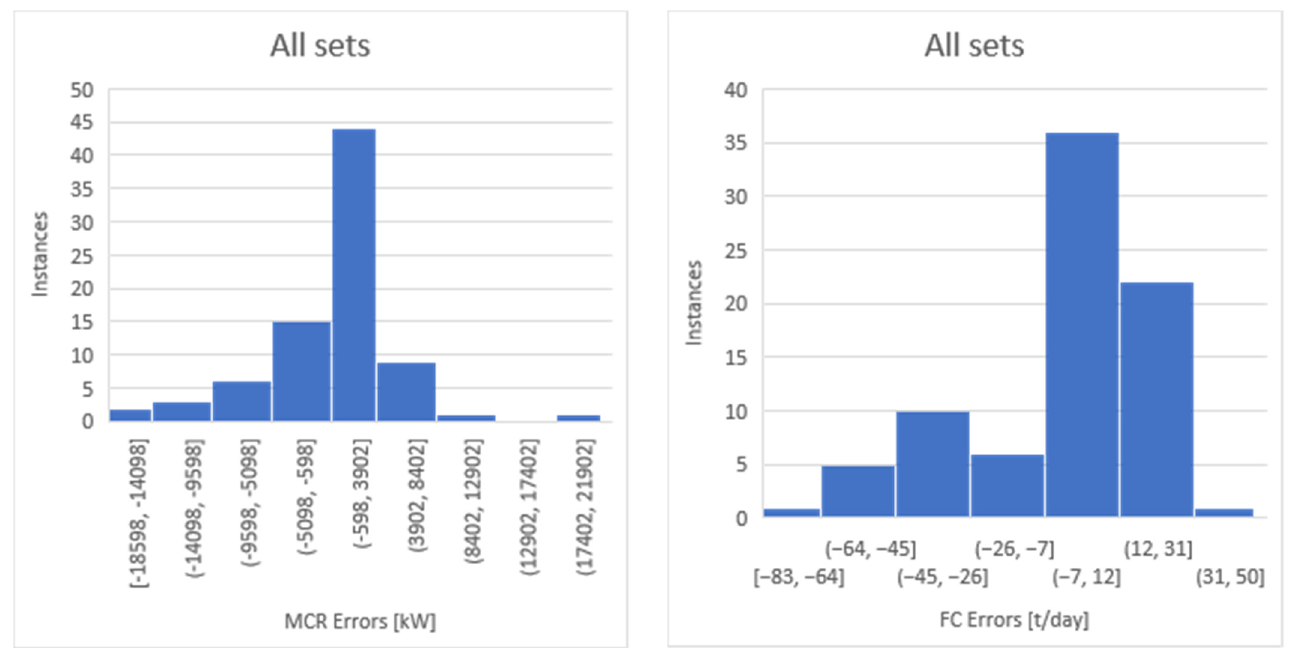
Figure 14. Error histograms of the artificial neural network to estimate the engine power (MCR) and fuel consumption (FC)